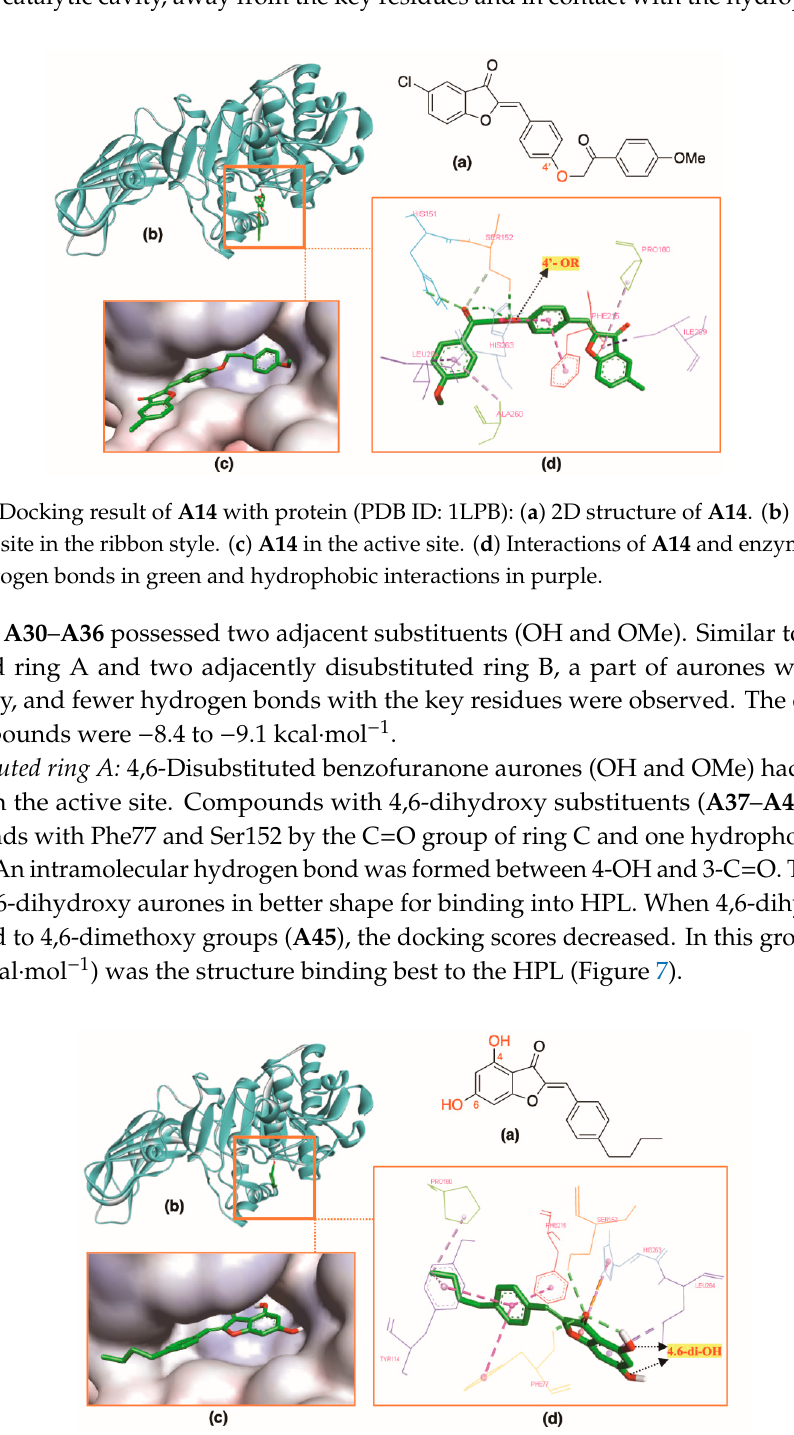
Figure 7. Docking result of A42 with protein (PDB ID: 1LPB): ( a ) 2D structure of A42 . ( b ) A42 inside the active site in the ribbon style. ( c ) A42 in the active site surface. ( d ) Interactions of A42 and enzyme residues with hydrogen bonds in green and hydrophobic interactions in